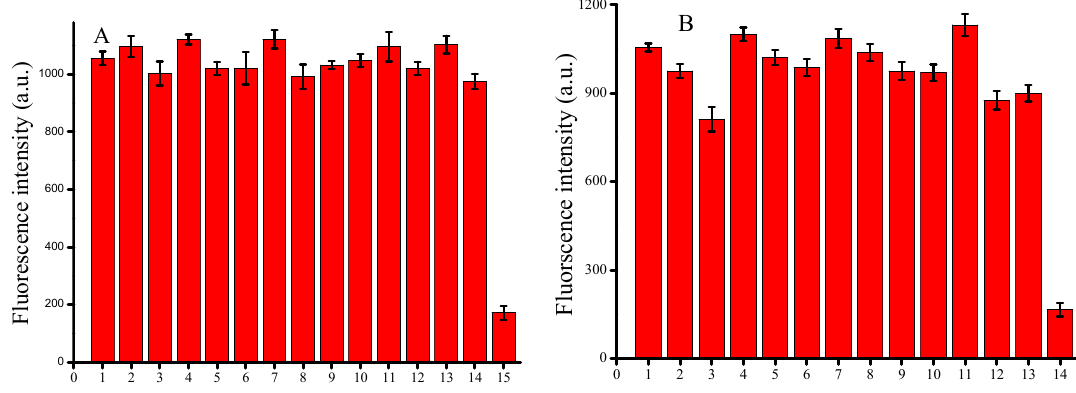
Figure 5. ( A ) Fluorescence emission spectra of the reaction system with HSA (7 µM) and various ions (7 µM) under the optimized concentrations. 1, Blank; 2, K + ; 3, Mn 2+ ; 4, Ca 2+ ; 5, Na + ; 6, Mg 2+ ; 7, Li + ; 8, Al 3+ ; 9, Zn 2+ ; 10, Hg 2+ ; 11, Cl − ; 12, NO 3 − ; 13, SO 42 − ; 14, CO 32 − ; 15, HAS; ( B ) Fluorescence emission spectra of the reaction system with HSA (7 µM) and various organics (7 µM) under the optimized concentrations. 1, Blank; 2, arginine; 3, glutamic; 4, glycine; 5, isoleucine; 6, leucine; 7, lyscine; 8, valine; 9, proline; 10, alanine; 11, glucose; 12, sucrose; 13, carbamide; 14, HSA.